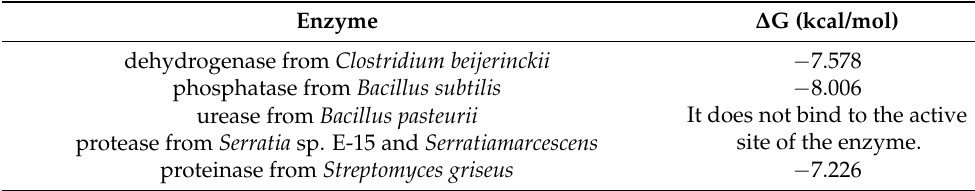
Table 2. Interacting energies of oxyfluorfen with enzymes secreted by soil